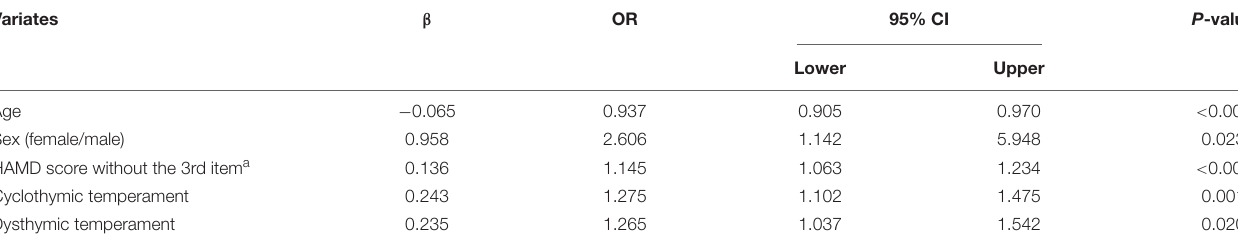
TABLE 5 | Factors associated with suicidal risk in MDD: multivariate logistic regression analysis.